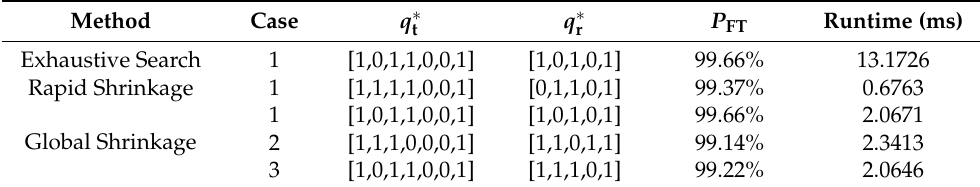
Table 1. Simulation of different selection strategies.